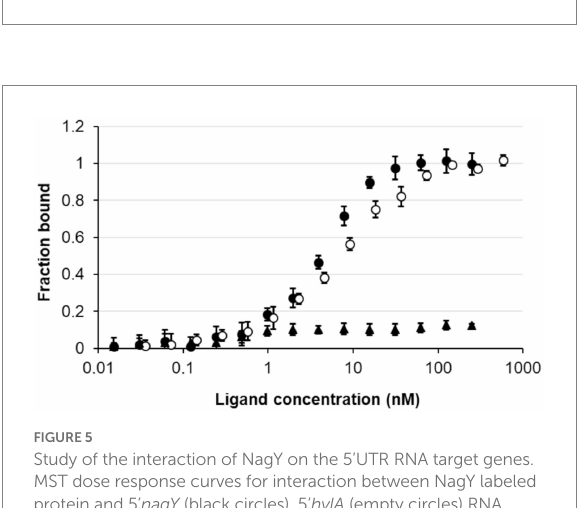
FIGURE 5 Study of the interaction of NagY on the 5’UTR RNA target genes. MST dose response curves for interaction between NagY labeled protein and 5’ nagY (black circles), 5’ hylA (empty circles) RNA (ligand), and SRC65 sRNA (used as negative control; black triangles). Error bars represent the standard error of triplicate